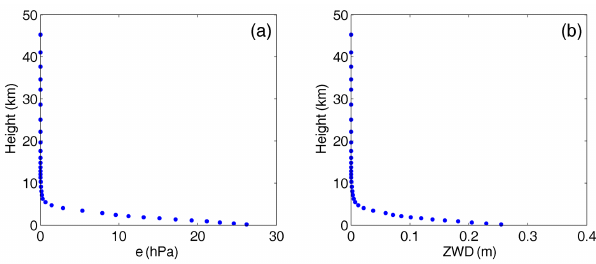
Figure 1. Water vapour pressure profile (a) and ZWD profile (b) at a grid point (0 ◦ N, 0 ◦ E) at 12:00UTC on 1 January